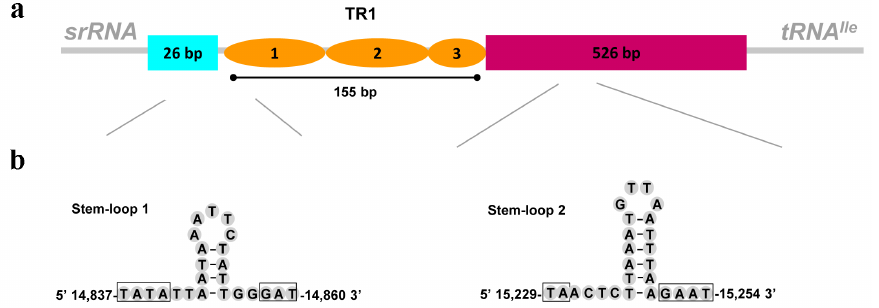
Figure 5. Organization of the control region in S. fasciata mitogenome. ( a ) control region structure of S. fasciata. TR is the abbreviation of tandem repeat units; ( b ) putative stem–loop structures found in the control region of S. fasciata.